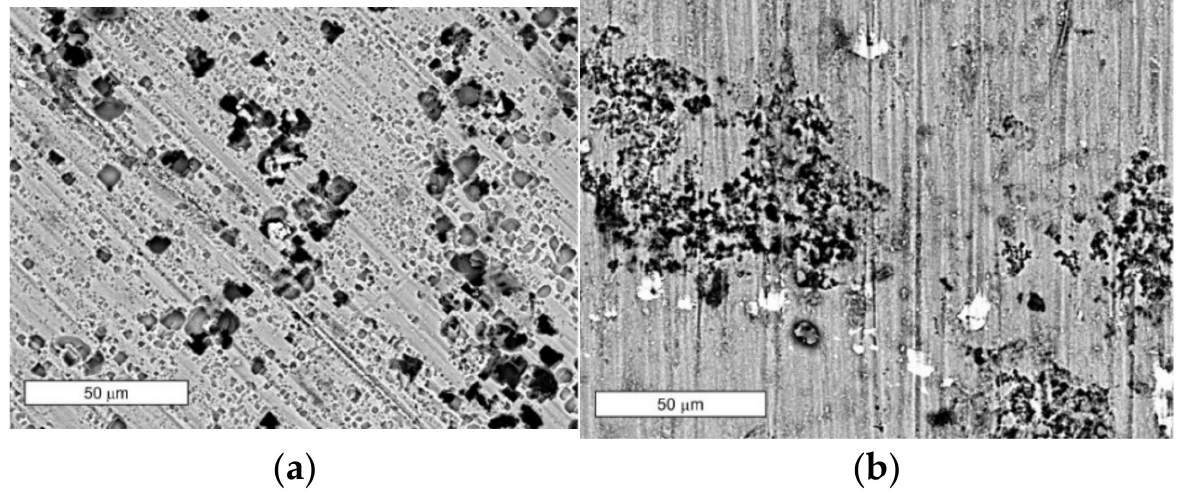
Figure 18. Corrosion with a clear character of a crystallographic attack observed on the surface of the sample after electrochemical tests in the T6 ( a ) state and localized corrosion in the sample DA ( b );